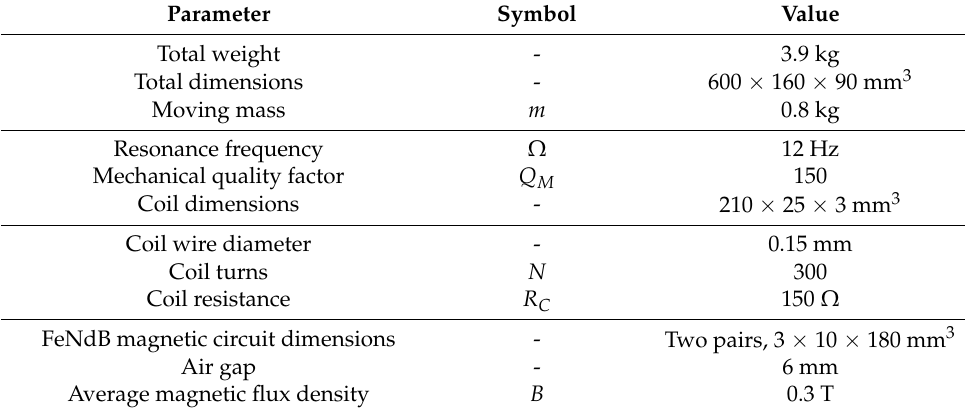
Table 1. Parameters of individual harvesters used in experiments.